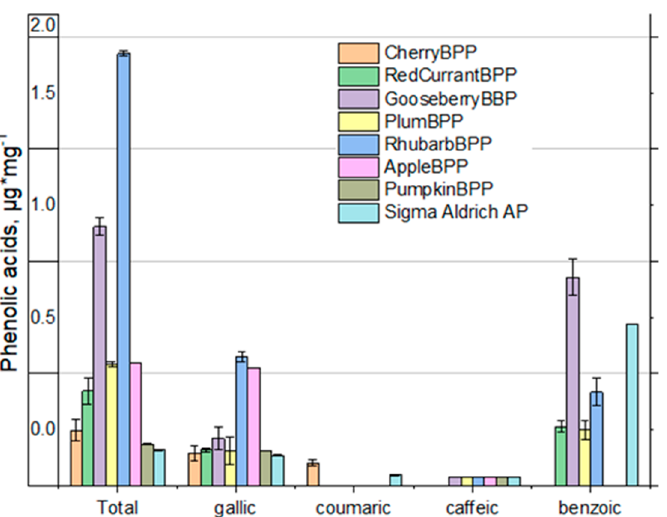
Figure 3. Phenolic acid profile of pectin samples (HPLC). Each pectin sample was prepared in three replicates and subsequently analyzed in triplicate.